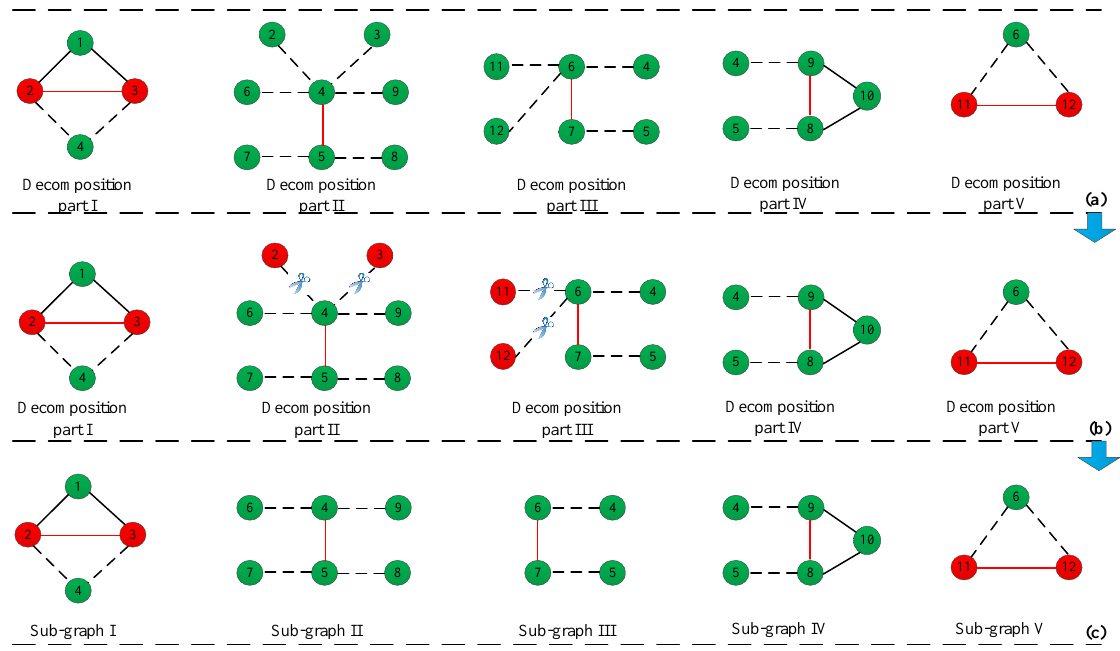
Figure 4. Sub-graph extraction from the attributed graph. ( a ) The initial sub-graphs of different decomposition part; ( b ) discarding the vertices labeled as “T” from the initial sub-graphs; and ( c ) final sub-graphs of different decomposition parts. Note that the edge colored in red indicates a ridge line contained in the compound building, the red vertices indicate that the attributes of these vertices are labeled as “T”, and the dotted line in the sub-graphs indicates that the two vertices are adjacent planar patches but one of them is not contained in the corresponding decomposition